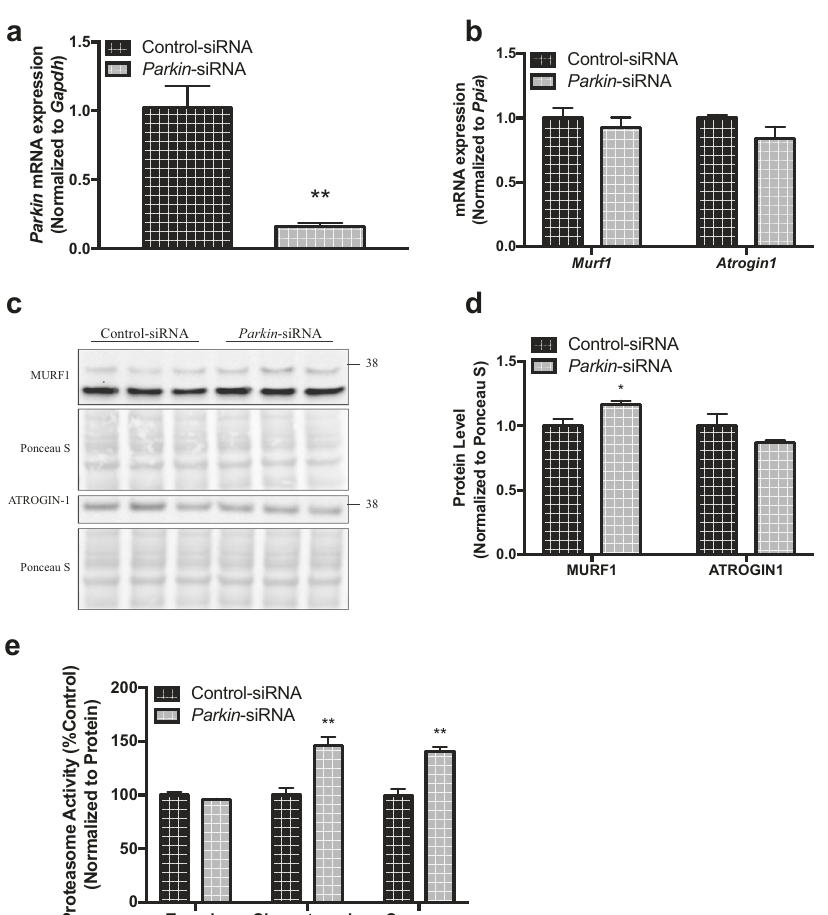
Fig. 1 Parkin knock down increases 20S proteasomal activity in C2C12 myotube model. a Graph showing Parkin mRNA levels in non- targeting Control-siRNA and Parkin -siRNA transfected C2C12 myotubes. b Graph showing qPCR analysis of atrogenes Murf1 and Atrogin1 in Control-siRNA and Parkin -siRNA transfected myotubes. c Representative images of western blot analysis of MURF1 and ATROGIN-1 in Control- siRNA and Parkin -siRNA transfected myotubes. The levels of Ponceau-S were assessed as a loading control. d Graph showing quanti fi cation of protein levels of MURF1 and ATROGIN-1. e Graph showing three major 20S trypsin-like, chymotrypsin-like and caspase-like proteasomal activities in Control-siRNA and Parkin -siRNA transfected myotubes. Relative light units (RLU) were normalized to total protein and represented as percentage as compared to the control. Data represent mean±s.e.m. with error bars indicating s.e.m., n.s. not signi fi cant, * P < 0.05, ** P < 0.01 (two-tailed Student ’ s